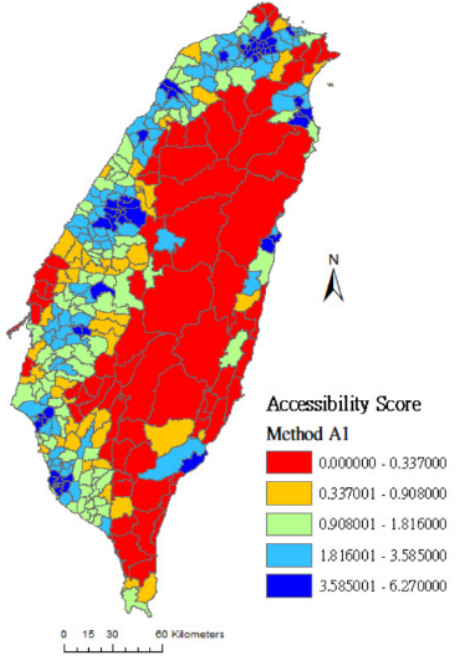
Figure 2. Accessibility score of rehabilitation physician service in Taiwan using method A1.